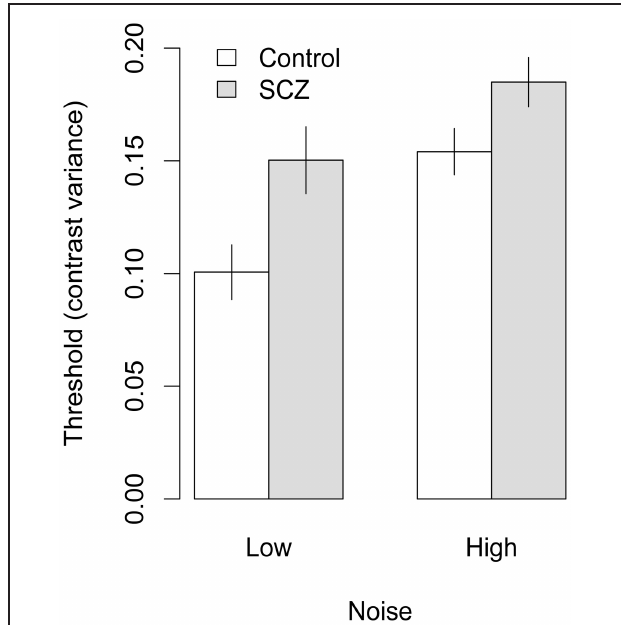
FIGURE 5 | Face identification thresholds measured with inverted faces and expressed in terms contrast variance. In both high and low noise conditions, people with SCZ demonstrate higher thresholds, and thus, decreased performance for inverted face identification. Error bars represent ± 1 standard error.